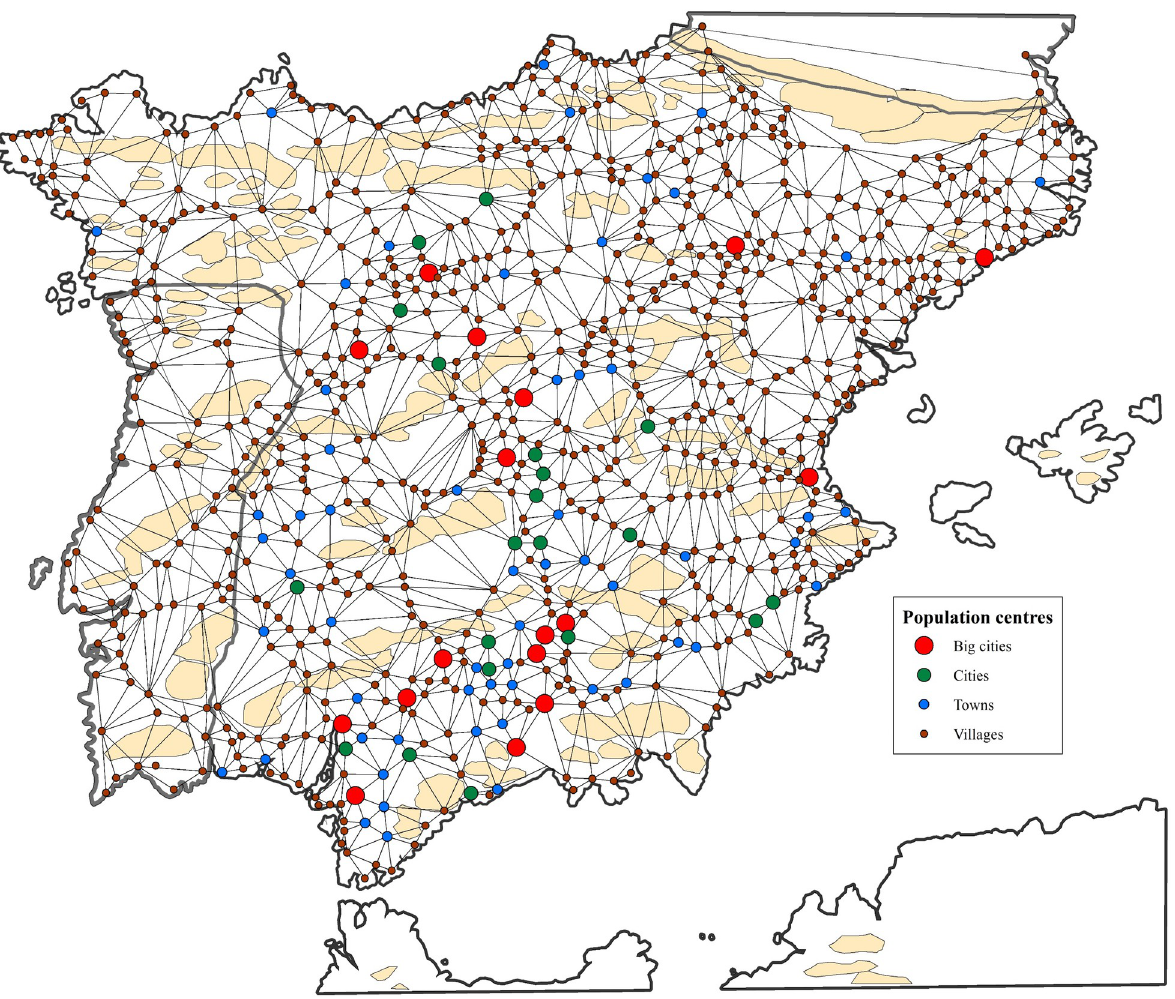
Fig 11. The Iberian Road na ï ve map of the late 16 th century. Notes: The design of the network was made by adding to the available historical information the results obtained from the model in a similar way as in Fig 10, but now using the map of Forlani [117] as a spatial reference. Source: Produced by the authors from D’Ocampo [107], Villuga [63], Estienne [108], Gail [109], Stella and L’Herba [110], Meneses [64], Rowlands [111], and Hogenberg [112], and Forlani [117].